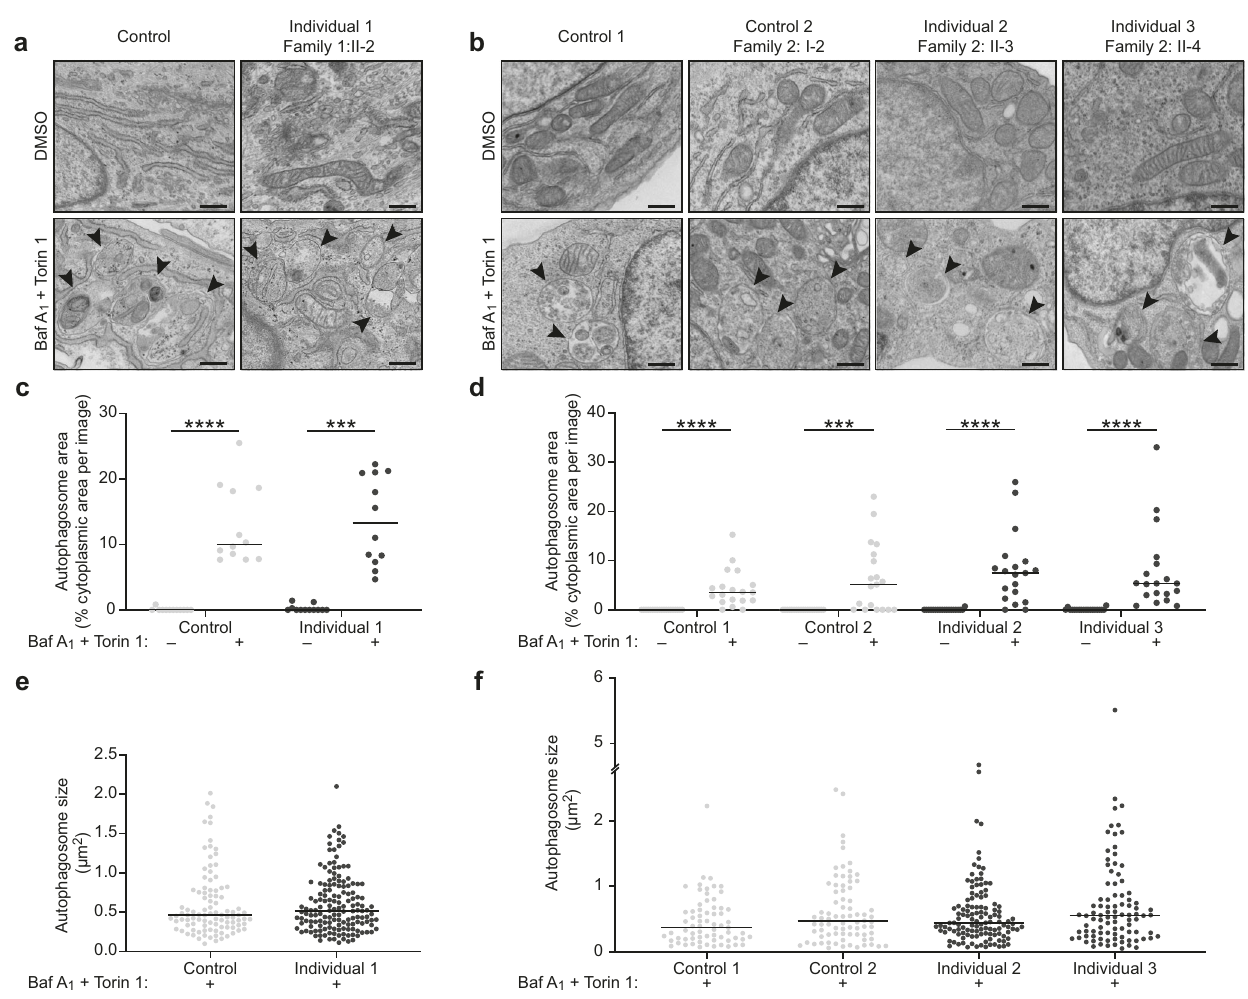
Fig. 2 Transmission electron microscopy analyses of autophagosome biogenesis in cultured cells from individuals with bi-allelic variants in ATG4D . a , b Representative TEM images of cultured primary fi broblasts from Control (GM09503) and Individual 1 ( a ) or lymphoblastoid cell lines from Control 1 (CCL-104), Control 2 (Family 2: I-2, mother of Individuals 2 and 3), Individual 2 (Family 2: II-3), and Individual 3 (Family 2: II- 4) (B) treated with vehicle (DMSO) or 100 nM Torin 1 and 100 nM Ba fi lomycin A 1 for 3 h to induce the formation of autophagosomes and to prevent their degradation, respectively (arrowheads). c – f Quanti fi cation of autophagosome area ( c , d ) and size ( e , f ) from the experiments represented in ( a , b ). The data are presented as dot plots with the median indicated by a horizontal line. Light gray data points represent measurements made on control cells; dark gray data points represent measurements made on affected cells. For the quanti fi cation of autophagosome area, 12 images (primary fi broblasts) or 19 images (lymphoblastoid cell lines) taken from each sample were assessed per condition. A Kruskal – Wallis test and Dunn ’ s multiple comparisons test were performed for relevant prede fi ned dataset pairs. For the quanti fi cation of autophagosome size, data points represent individual autophagosomes measured from Torin 1- and Ba fi lomycin A 1 -treated conditions. For the primary fi broblasts, n = 98 and n = 152 autophagic structures were respectively measured for Control (GM09503) and Individual 1 (Family 1: II-2), and a two-tailed Mann – Whitney U test was performed. For the lymphoblastoid cell lines, n = 67, n = 78, n = 122, and n = 92 autophagomsomes were respectively measured for Control 1 (CCL-104), Control 2 (Family 2: I-2, mother of Individuals 2 and 3), Individual 2 (Family 2: II-3), and Individual 3 (Family 2: II-4), and a Kruskal – Wallis test and Dunn ’ s multiple comparisons test were performed